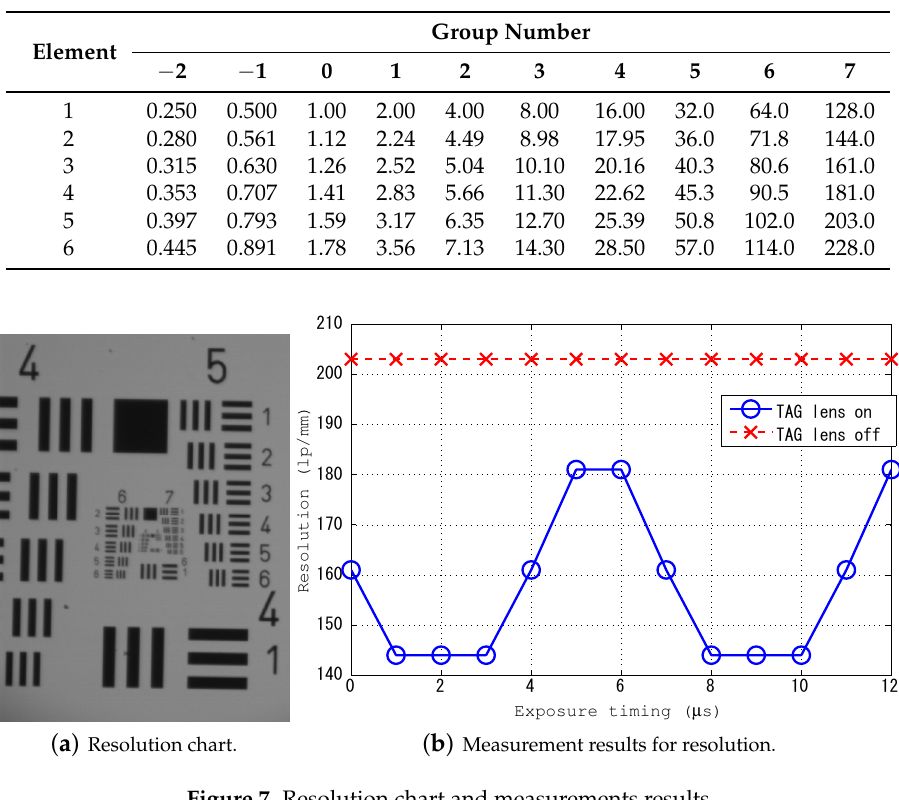
Table 1. Resolution measurements. This table is used in correspondence with the captured image of the chart shown in Figure 7a.